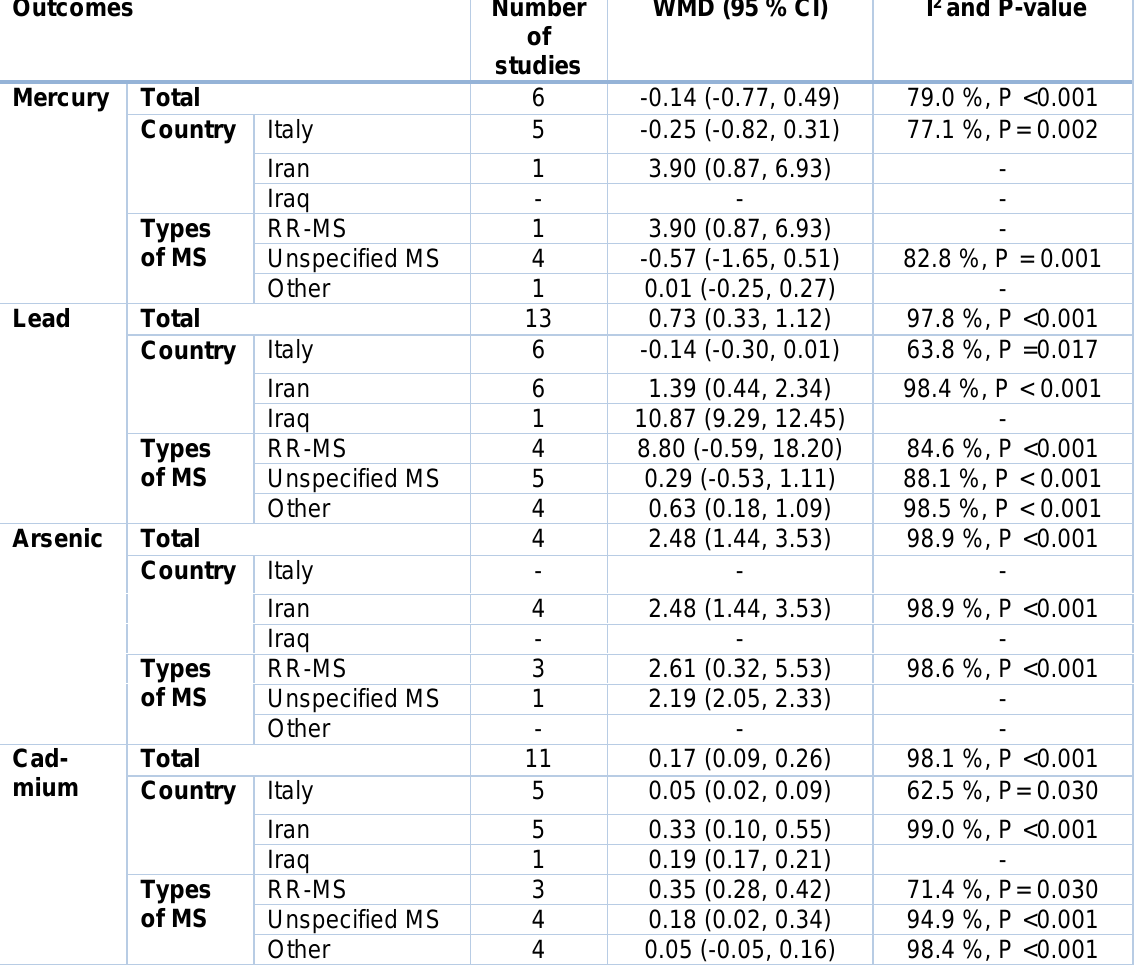
Table 2: Findigs of subgroup analyses